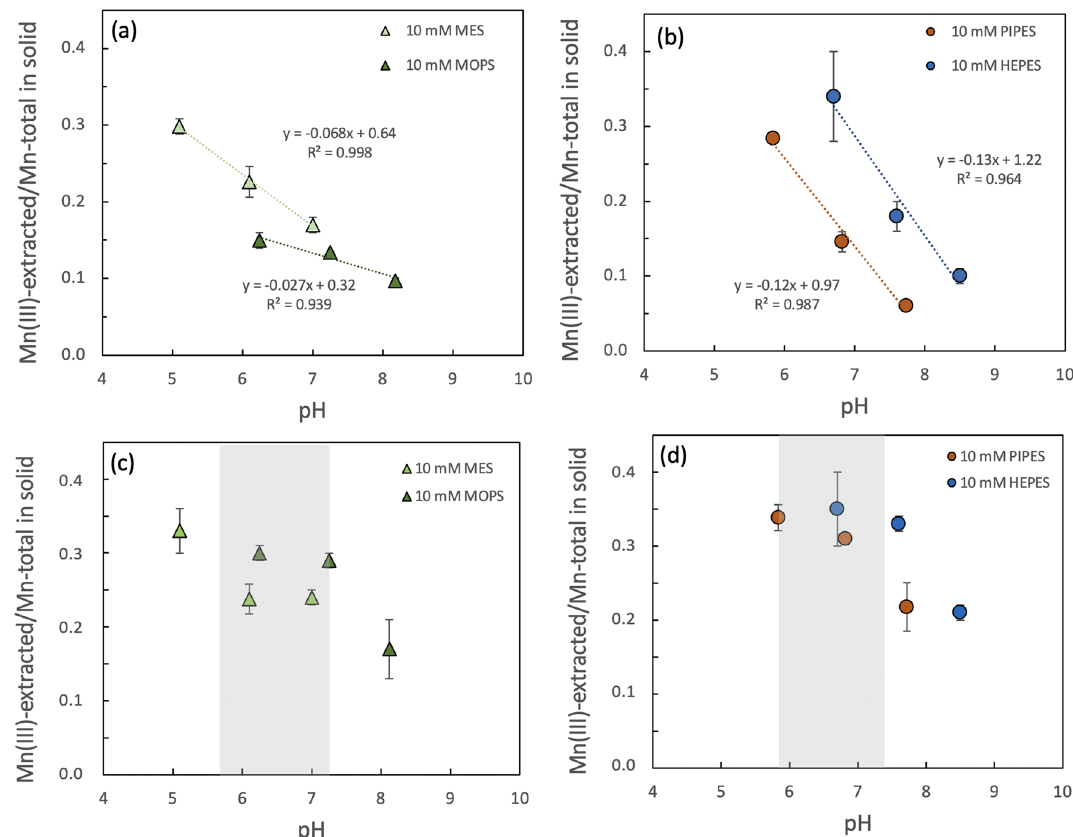
Figure 2. Pyrophosphate-extracted Mn(III)-content of δ-MnO 2 reacted with buffers containing a morpholine ( a, c ) versus piperazine ring ( b, d ) as a function of pH after 1 h ( a, b ) and 24 h ( c, d ). Linear regressions show similar slopes for similar buffer structure after 1 h. At 24 h, grey bars denote the circumneutral pH region where Mn reduction is less responsive to pH. Error bars represent standard deviation of triplicates, when not visible error bars are smaller than the marker